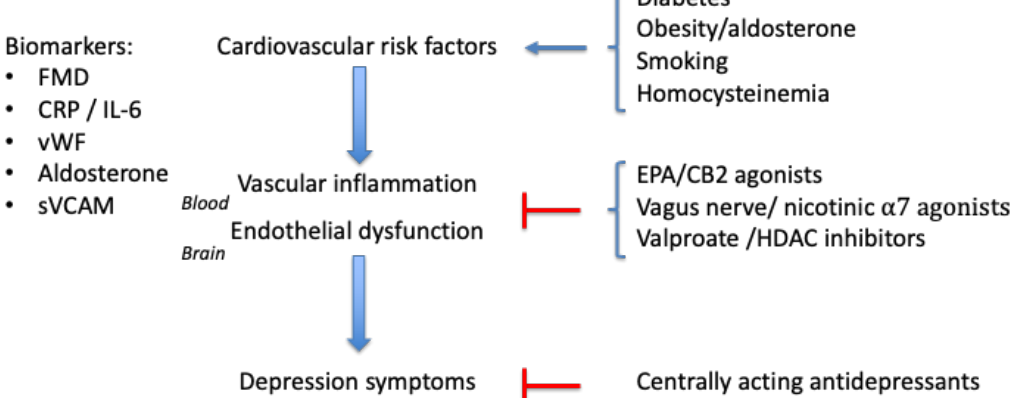
Figure 2. Diabetes and other risk factors for atherosclerosis promote vascular inflammation and endothelial dysfunction. Biomarkers for this process are FMD (flow-mediated dilation), CRP (C-reactive protein), proinflammatory cytokines like interleukin-6, von Willebrand factor (vWF), aldosterone, or soluble vascular cell adhesion molecule (sVCAM). Putative treatments specific for depression secondary to vascular inflammation are eicosapentaenoic acid (EPA), cannabis CB2 receptor agonists, Vagus nerve stimulation, agonists for the nicotinic α 7 receptors, and HDAC (histone deacetylase) inhibitors, like valproate.